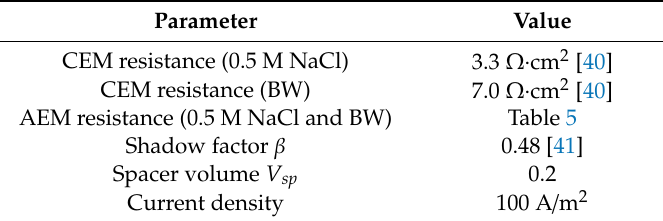
Table 6. Parameters used for the ED